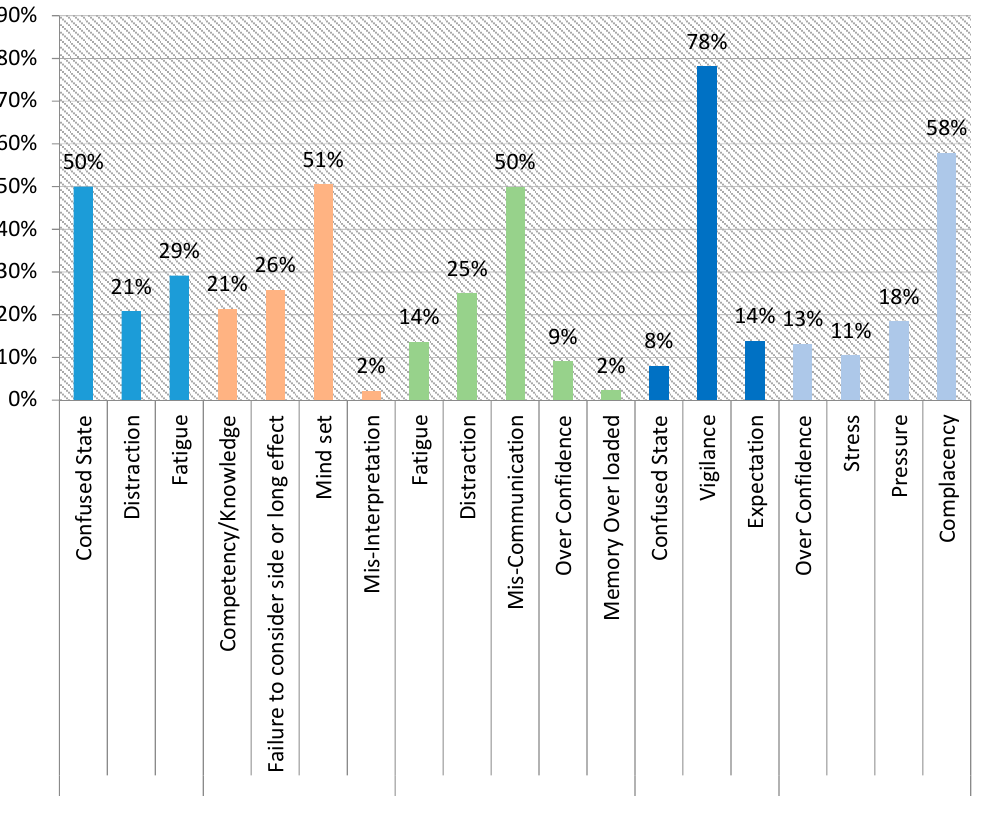
Figure 10. Percentages for the Psychological Error Mode (PEM).